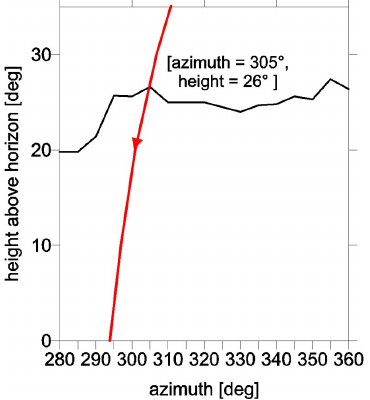
Figure 5: Altitude profile in direction from west to north for sunset.